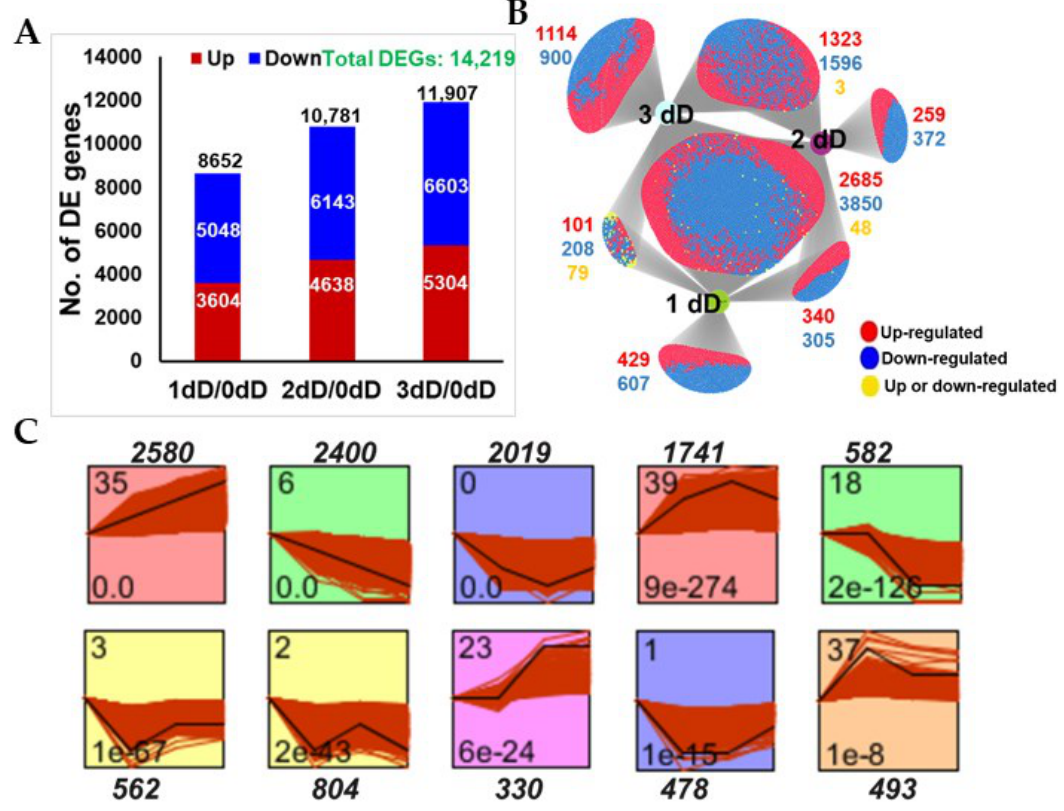
Figure 5. Transcriptomic analysis of dark-induced senescence in M. truncatula . ( A ) Number of differentially expressed genes (DEGs) ( Padj ≤ 0.05, Log2FC ± 1) at 1 dD, 2 dD, 3 dD vs. 0 dD (dD—day after dark treatment), calculated from the FPKM values from three biological replicates for each time point. ( B ) Venn diagram showing overlap among DEGs at 1 dD, 2 dD, 3 dD vs. 0 dD using DiVenn. ( C ) STEM clustering of DEGs exhibiting similar temporal expression patterns at 0 dD, 1 dD, 2 dD and 3 dD. The numbers outside the boxes in ( C ) represent the gene numbers. The numbers in the upper left corner inside the boxes in ( C ) indicate the profile number, and in the lower left corner, the p values.